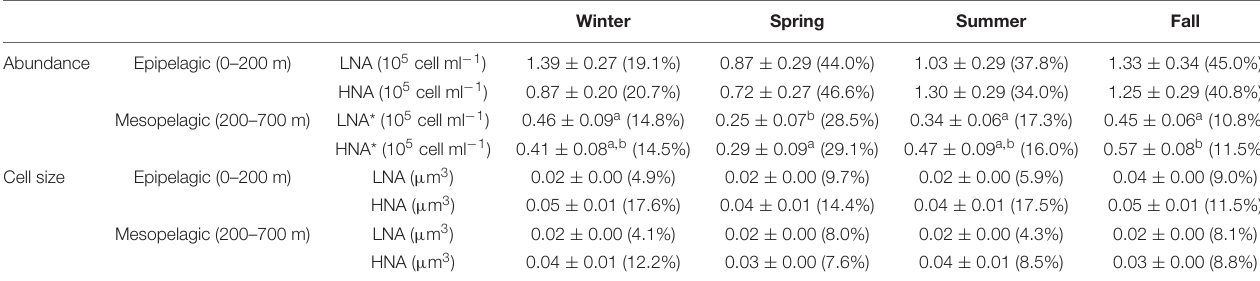
TABLE 2 | Depth-weighted averages of heterotrophic picoplankton abundances and cell sizes in the epipelagic (0–200 m) and mesopelagic (200–700 m) with the corresponding coefficients of variation (%) between parentheses in winter, spring summer, and